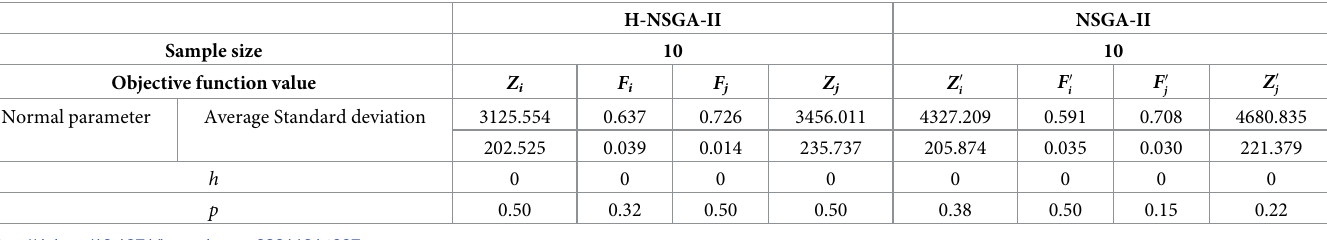
Table 7. Lilie-test analysis